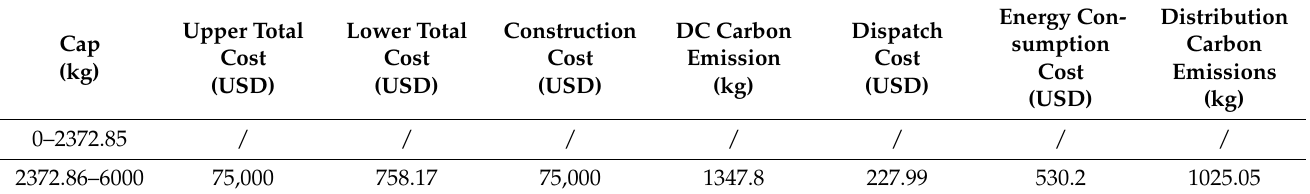
Table 11. Location-routing results under different carbon emissions